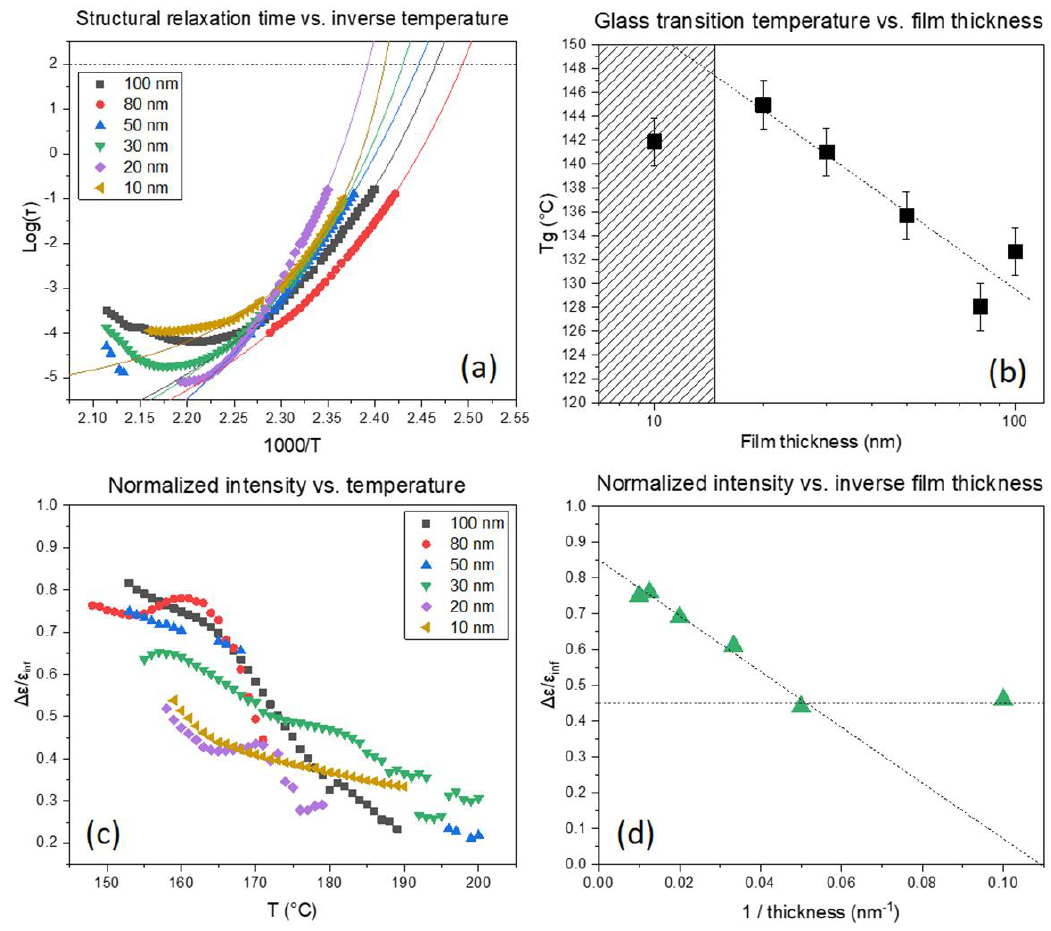
Figure 4. ( a ) The determined T g values for each thickness; ( b ) the normalized intensity versus temperature; ( c ) and the normalized intensity versus the inverse film thickness ( d ).